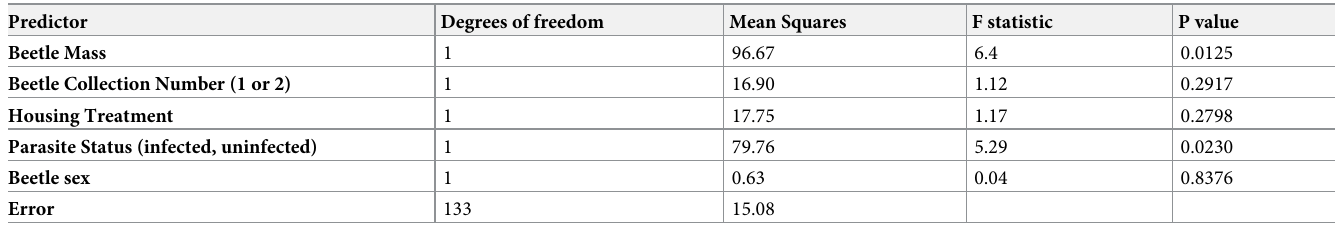
Table 2. Summary of general linear model that examined predictors of behavioral response scores (during simulated attack) in horned passalus beetles in this experiment. An interaction term between parasitism and housing treatment was not significant in a preliminary model (Davis, unpubl . data ). Predictor Degrees of